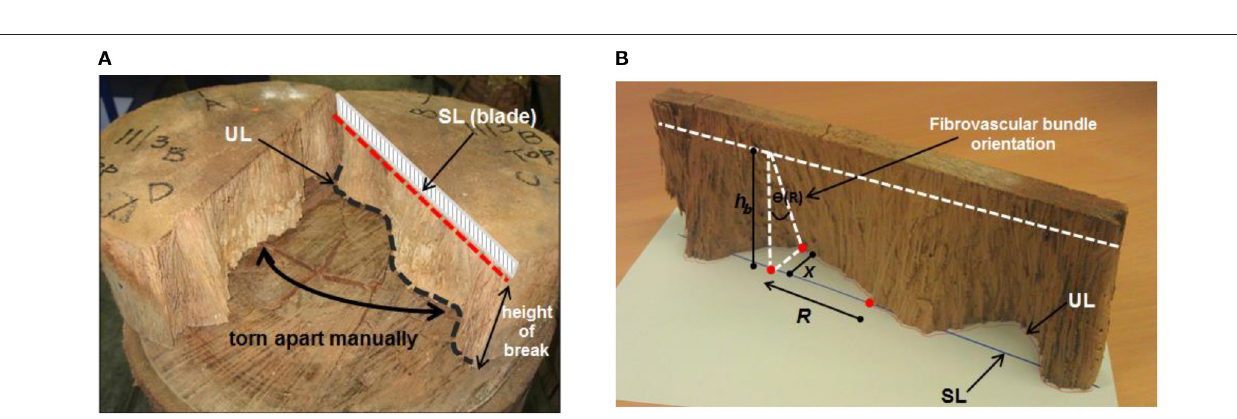
FIGURE 3 | (A) Each disc was split up to a depth of 10mm with a 1100mm long lathe-blade and manually torn apart. This left a straight split line (SL) on the upper face of the disc, where the blade was driven, and an undulated split line (UL) on the lower face that followed the fibrovascular bundles. (B) Measurement of the tangential fibrovascular bundle degree of